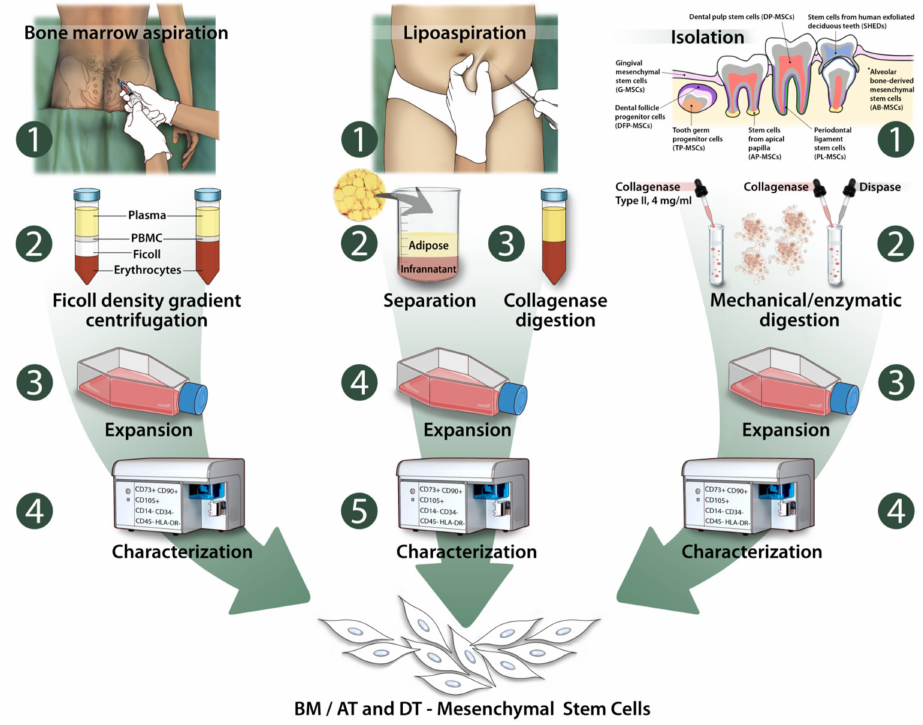
Figure 1. Bone marrow, adipose, and dental tissue as sources of stem